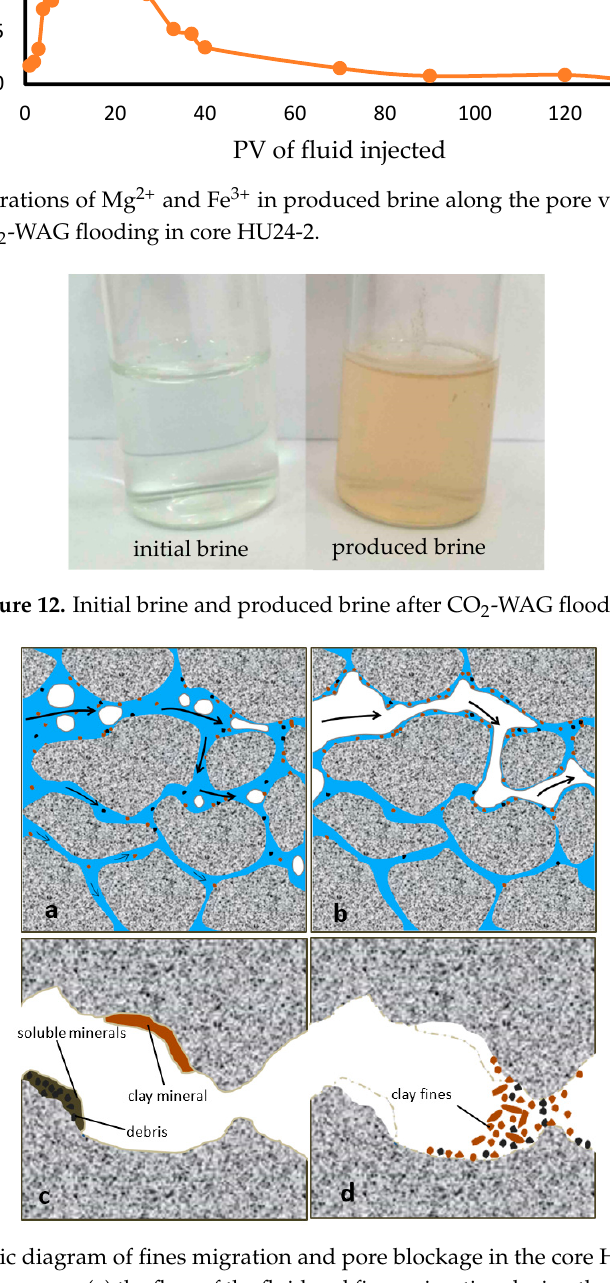
Figure 13. Schematic diagram of fines migration and pore blockage in the core HU24-2 and HU24-3 during the flooding process. ( a ) the flow of the fluid and fines migration during the CO 2 -WAG flooding; ( b ) the flow of the fluid and CO 2 and fines migration during the CO 2 flooding; ( c ) the shape of the pores and minerals before the flooding; ( d ) fine release due to mineral dissolution and formed blockage in the pore after the flooding.